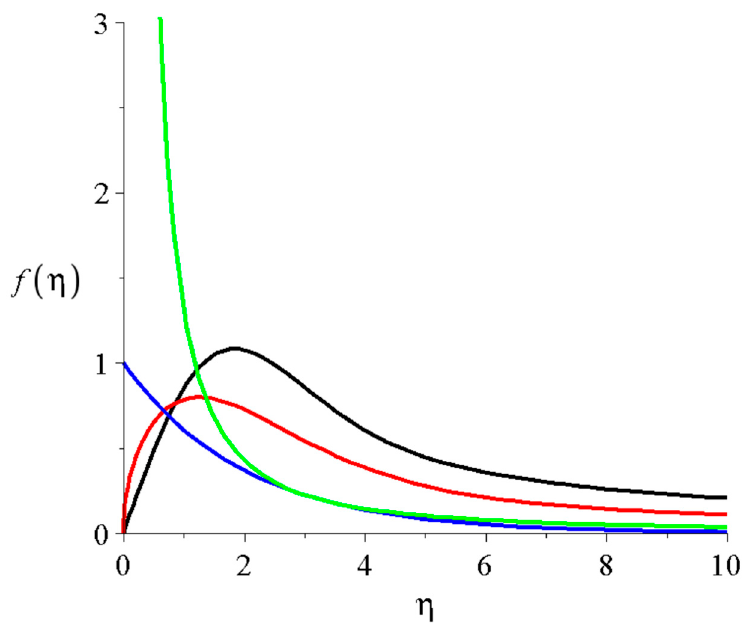
Figure 1. The solution of Equation (3) with D = 1; 𝛼 = 1/2 ; c 1 = 1; c 2 = 0: the black, red, blue, and green lines are for ( m = 0; 1/2; 1; 5/2).